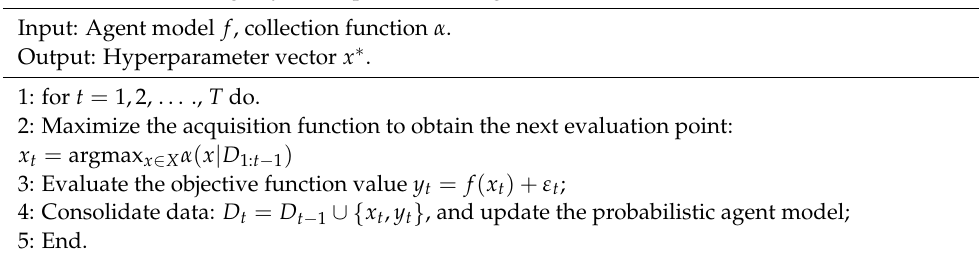
Algorithm 1: Labeling Bayesian optimization